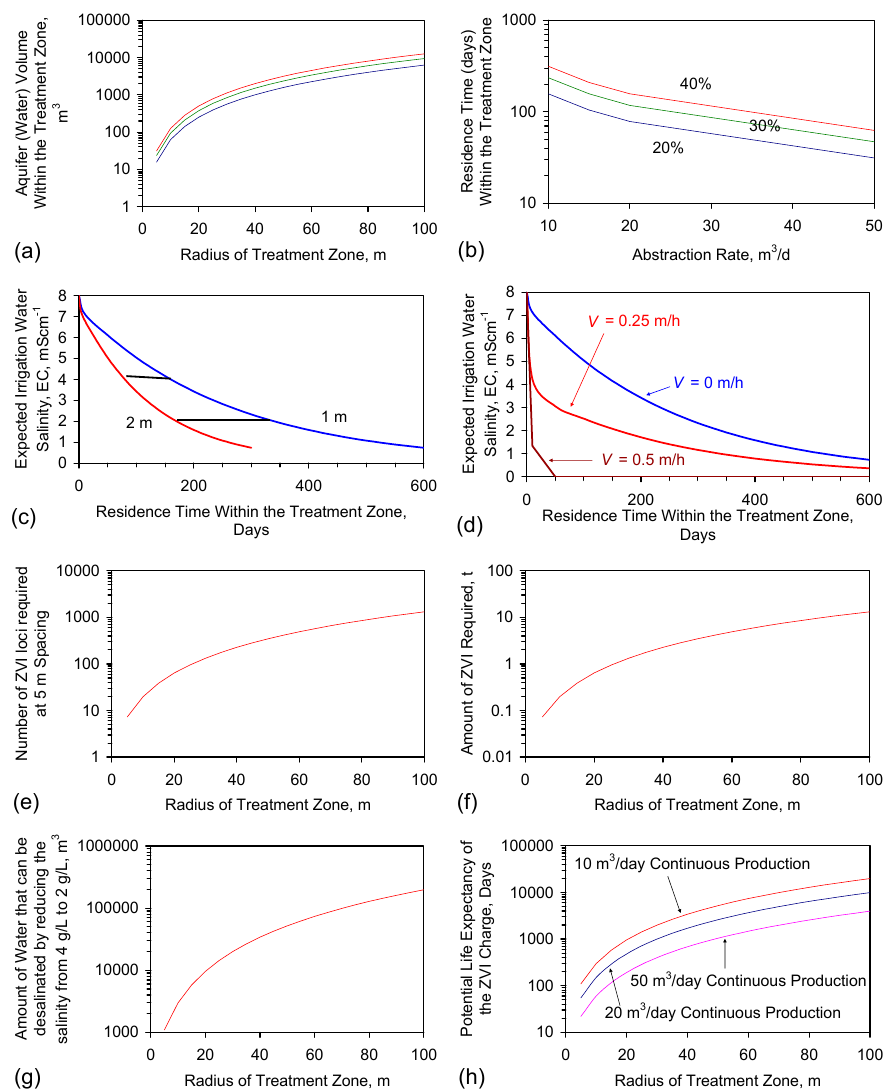
Figure C3. Example Modeled Aquifer Treatment Zone parameters. ( a ) Stored water volume in the aquifer within a radial distance of the abstraction well for porosities of 20%, 30% and 40%; ( b ) Residence time for the water within the a 100 m diameter) treatment zone as a function of aquifer porosity (20%, 30%, 40%) associated with continuous abstraction rates for irrigation in the range 10 to 50 m 3 /day. Aquifer thickness = 1 m; ( c ) Relationship between water residence time within the treatment zone, abstracted water salinity and aquifer thickness. The reference relationship is shown by the 1 m thickness case. The residence time required is independent of thickness but is dependent on the rate constant.